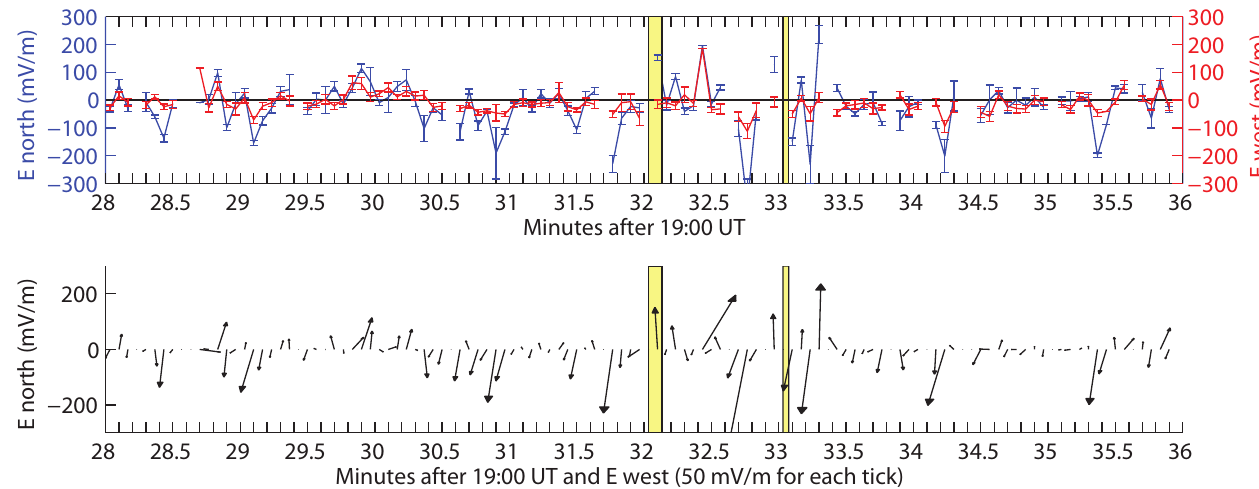
Fig. 11. Top: North and west components of the derived electric field from EISCAT, as a function of time. Bottom: Direction and amplitude of the electric field vector at each instant of time.